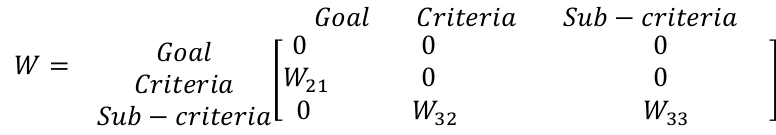
Fig. 6: The primary super-matrix structure; the situation of single-entry matrices